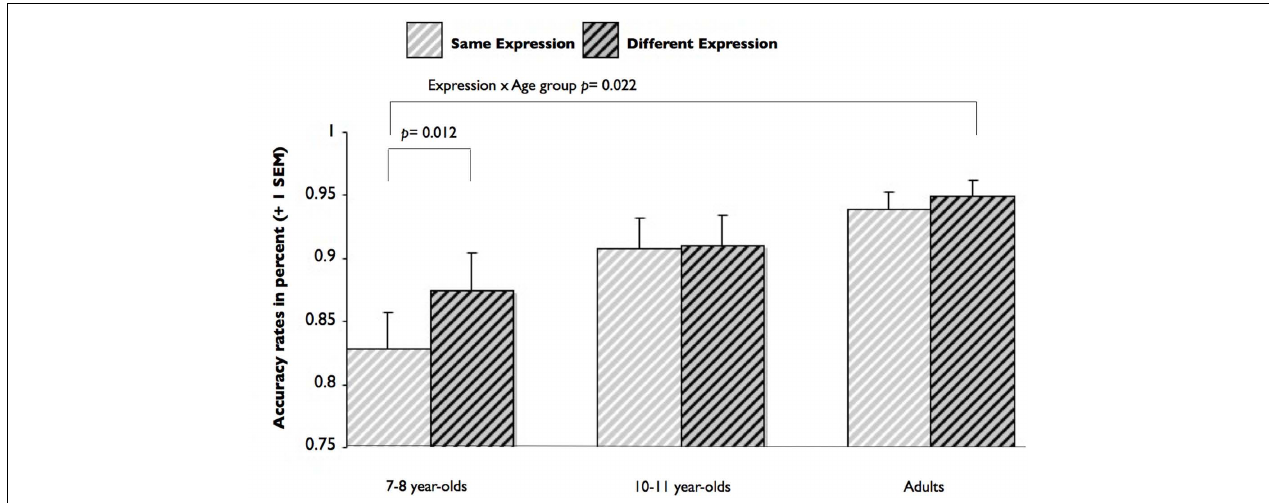
FIGURE 9 | Experiment 2: two-way interaction for expression × age group in the accuracy rates. This interaction was due to the group of 7- to 8-year-old children making significantly more mistakes in detecting expression changes.